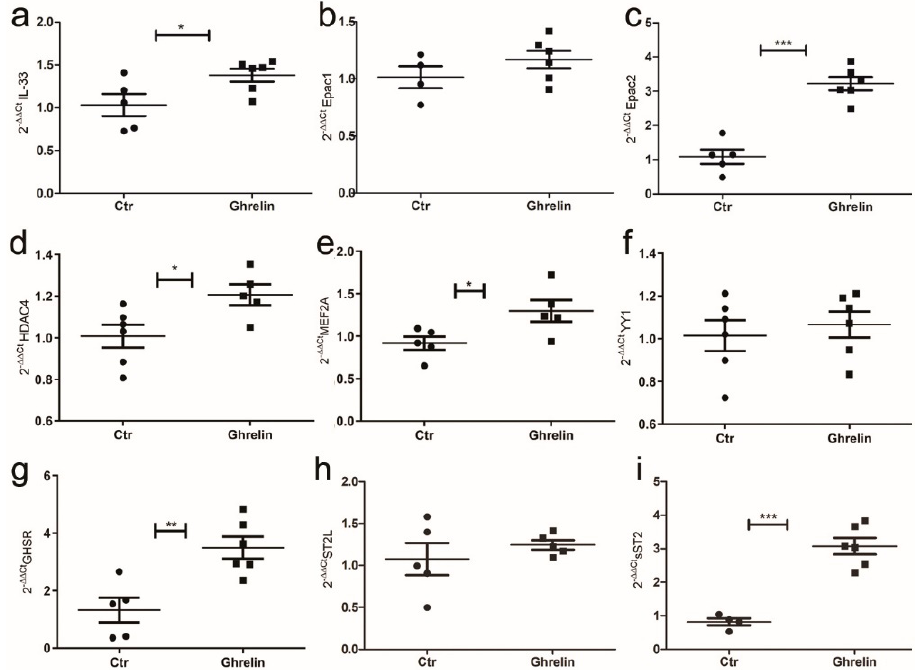
Figure 7. Ghrelin in vitro treatment of H9C2 cells modulated IL-33/ST2 signaling. Graphs showed qPCR of H9C2 cells treated with ghrelin or vector at 72 h. Ghrelin treatment enhanced ( a ) IL-33 and ( c ) Epac2 expression, while ( b ) Epac1 was unchanged. ( d ) Ghrelin treatment also induced HDAC4 and ( e ) MEF2A, while it did not alter YY1 expression ( f ). Ghrelin treatment enhanced ( g ) GHSR expression, while ( h ) ST2L was unaffected. ( i ) The sST2 mRNA was greatly increased by ghrelin treatment. Student’s t -test: * p < 0.05; ** p < 0.01, *** p < 0.001. Full square stands for Obese rats, while full circle stands for Lean